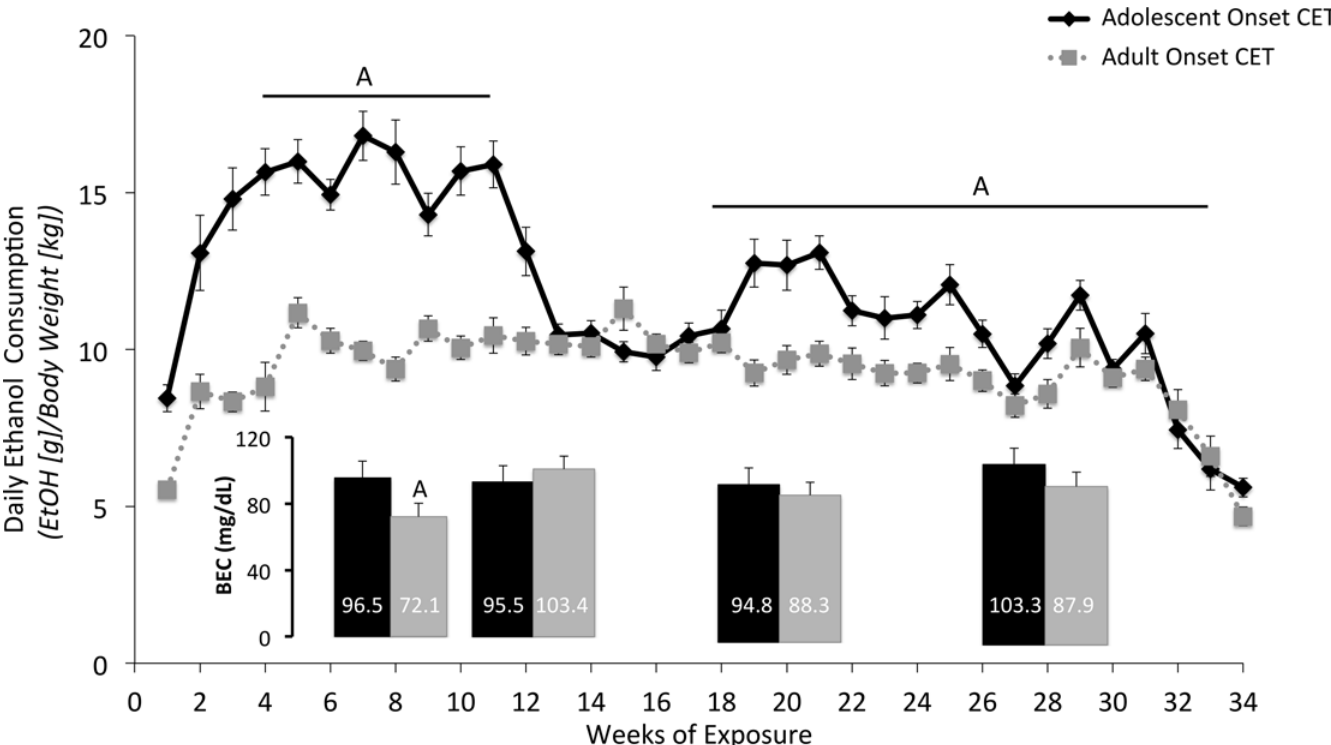
Fig 3. Adolescent onset of drinking, relative to adult onset, leads to higher EtOH consumption levels and initial higher blood ethanol concentrations. A difference in EtOH consumption was observed between the adult and adolescent CET onset rats on weeks 5 – 11 and 16 – 31, [A, p < 0.05], where adolescent onset rats consumed significantly more EtOH solution compared to adult onset rats. Despite significant differences in consumption, a significant difference in BEC was only observed after 1 month of CET [A, p < 0.05], where adolescent onset rats had significantly higher BEC levels compared to adult onset